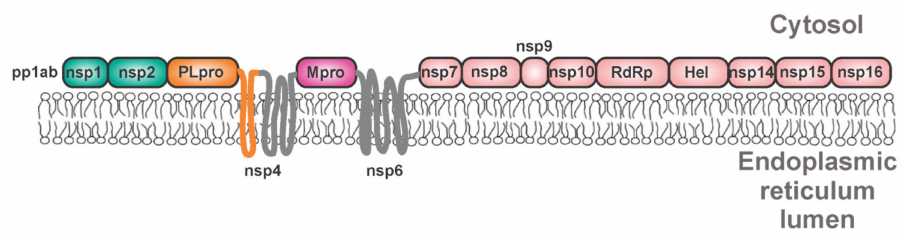
Figure 8. Polyprotein precursor pp1ab of SARS-CoV-2. Precursors of coronaviral proteases are anchored to the membrane of the endoplasmic reticulum by adjacent transmembrane domains of neighboring